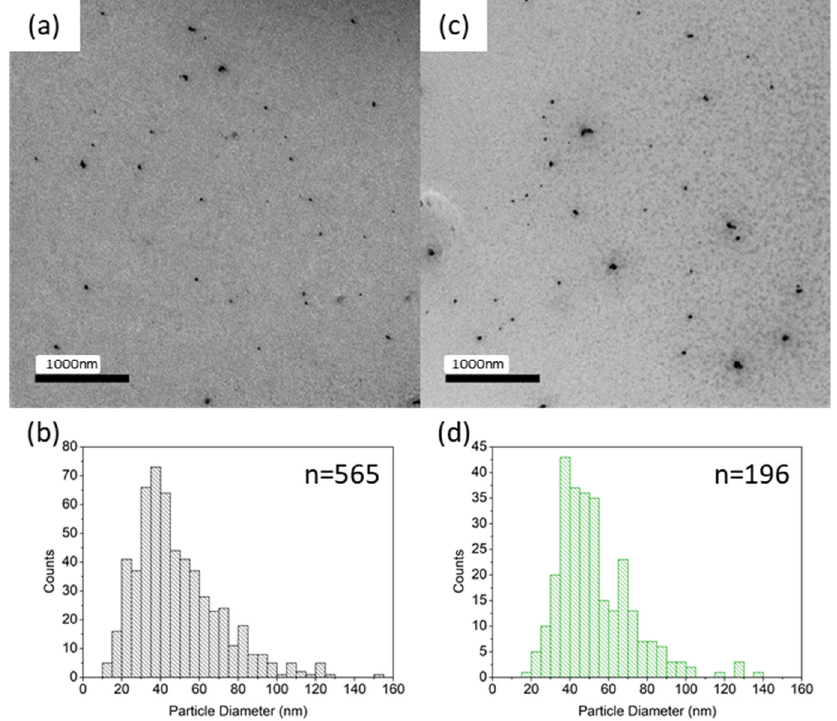
Figure 3. ( a ) Representative TEM image for compound 1-Sol : additional images available in the Supplementary Materials. ( b ) Particle length distribution for compound 1-Sol , where n = 565. ( c ) Representative TEM image for compound 1-Mech: additional images available in the Supplementary Materials. ( d ) Particle length distribution for compound 1-Mech , where n = 196 .